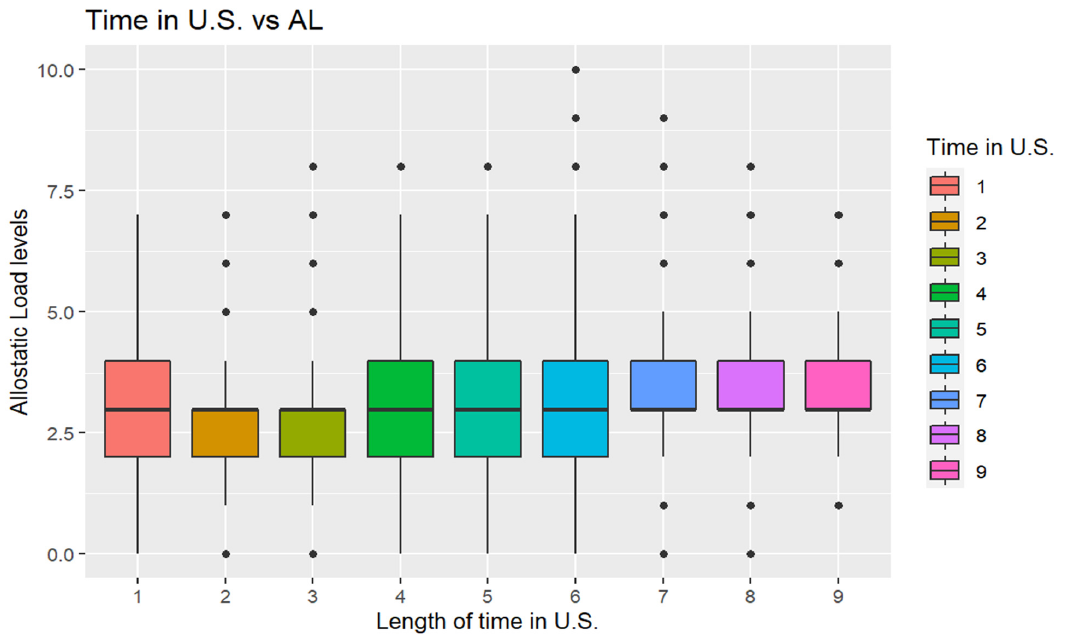
Figure 1. Boxplot (box and whisker plot) shows AL concentrations by length of time in U.S. Note: